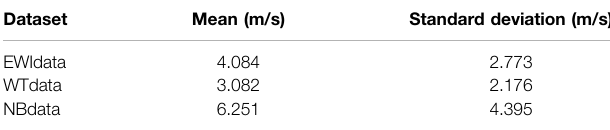
TABLE 2 | The mean and standard deviation of three different datasets.